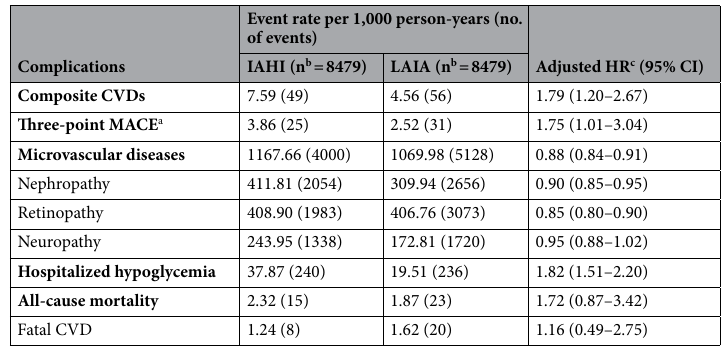
Table 2. Primary analyses for the event rate and hazard ratio (95% confidence interval) of study outcomes for intermediate-acting human insulin versus long-acting insulin analogue (reference group). IAHI, intermediate- acting human insulin; LAIA, long-acting insulin analogue; HR, hazard ratio; CI, confidence interval; CVD, cardiovascular disease; MACE, major adverse cardiovascular events. a Three-point MACE included non-fatal myocardial infarction, non-fatal stroke, and death due to cardiovascular diseases. b “n” refers to the number of stable use sets. c The variables adjusted in these analyses were age, gender, hospital grade, history of retinopathy, and cerebrovascular disease, which are shown to be statistically different between IAHI and LAIA users at baseline (in terms of standardized mean difference value of > 0.1) in Table 1.